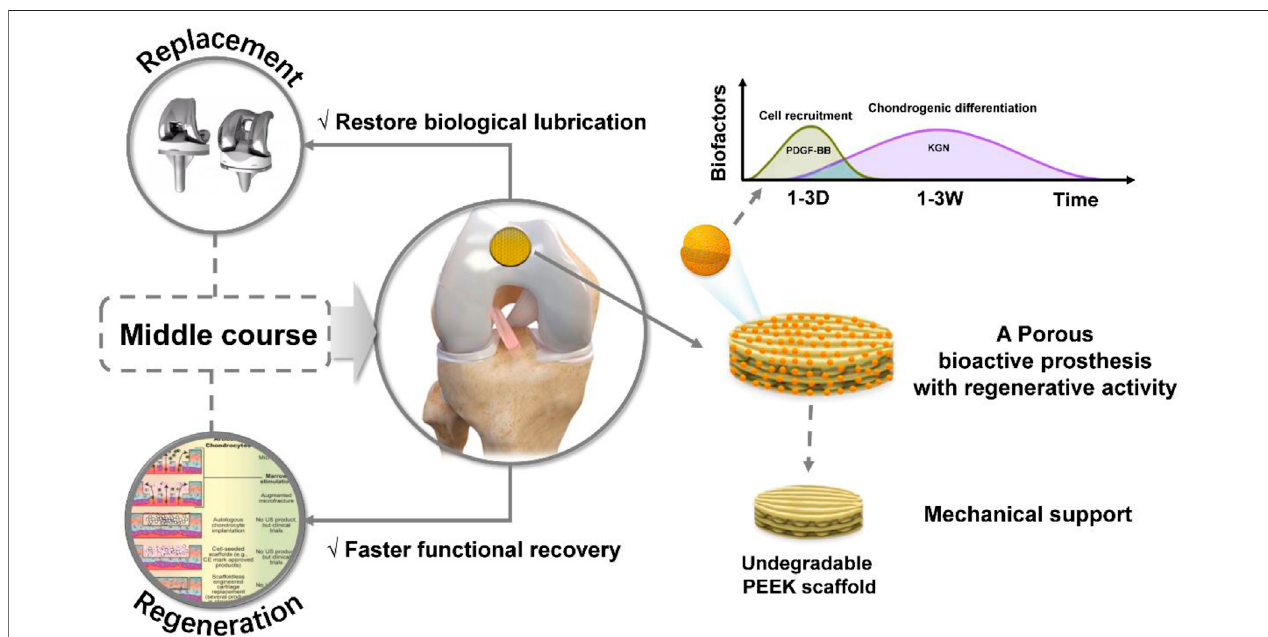
FIGURE8| Schematicdiagramoftheporousbioactiveprosthesiswithregenerativeactivityasanintermediateroutebetween “ replacement ” and “ regeneration ” for cartilage injury